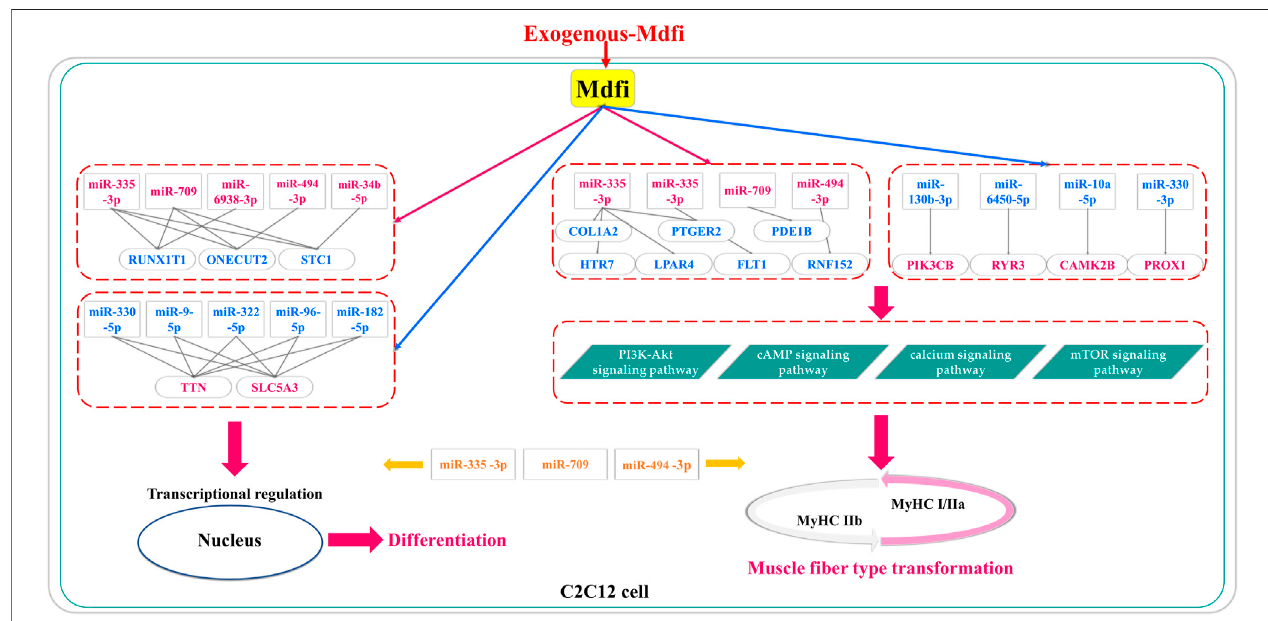
FIGURE 8 | The putative miRNA-mRNA interaction networks for Md fi overexpression on C2C12 cell differentiation and muscle fi ber type transformation. The upregulationsareshowninred,andthebluecolorrepresentsthedownregulation.Inparticular, miR-335-3p,miR-709,andmiR-494-3pwereinvolvedinregulatingboth myogenic differentiation and muscle fi ber type